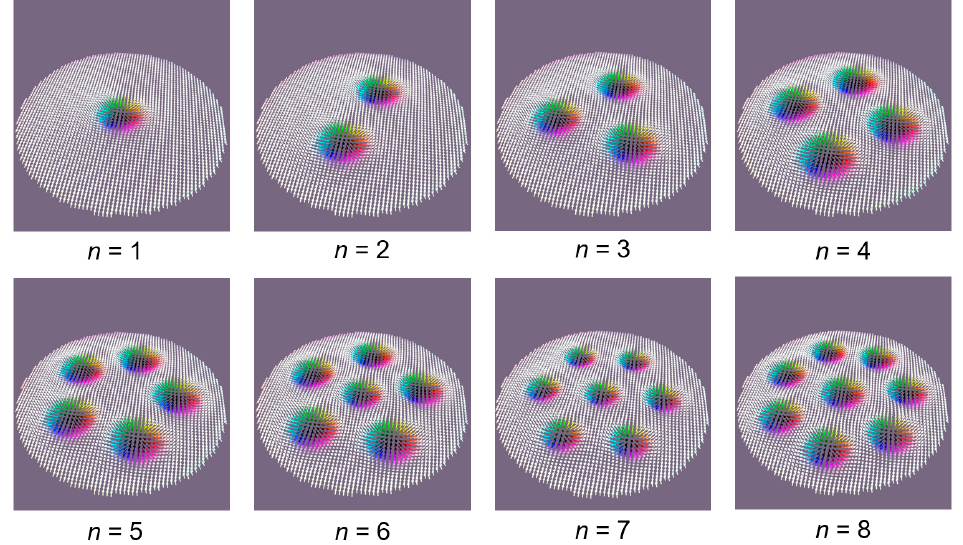
Figure 23. Multi-skyrmionic ground states obtained in 250 nm diameters disks.